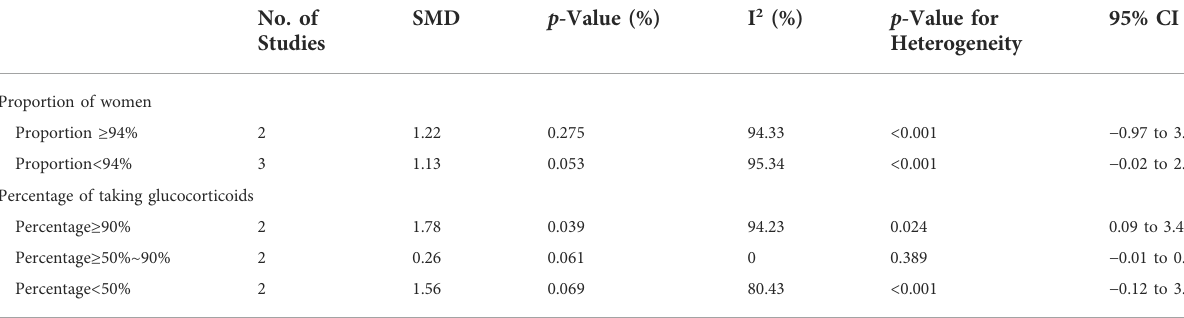
TABLE 3 Subgroup analysis in IL-6 according to the proportion of female SLE patients in total patients and the use of